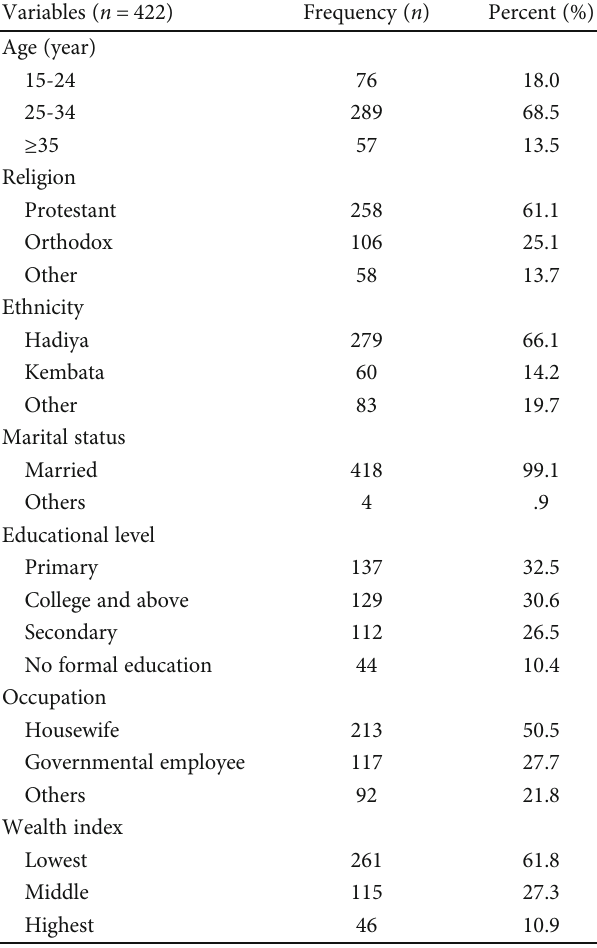
Table 2: Health care service utilization and obstetrics information of mothers with babies of one-month-old in Hossana town, southwest Ethiopia, 2018 ( n = 422